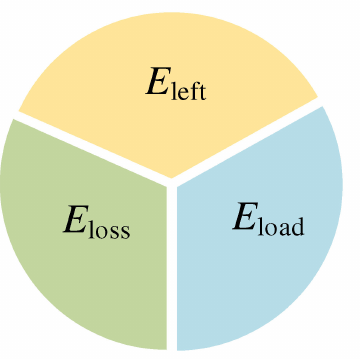
Figure 11. The distribution of energy stored in the super-capacitor in boost